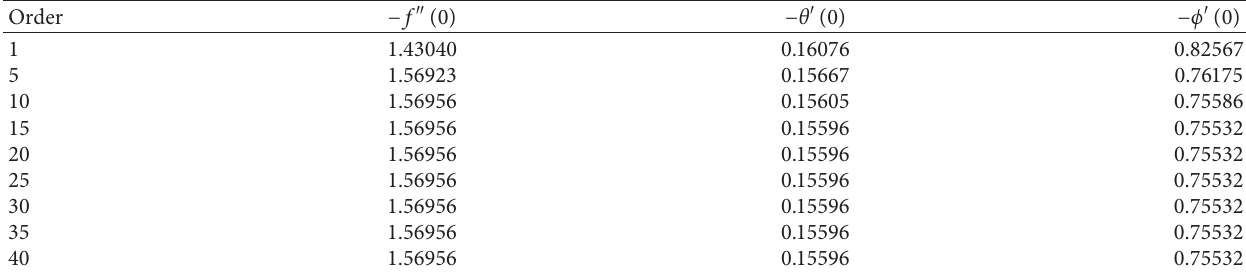
Figure 2: h-curves for h Table 1: Order of approximations of